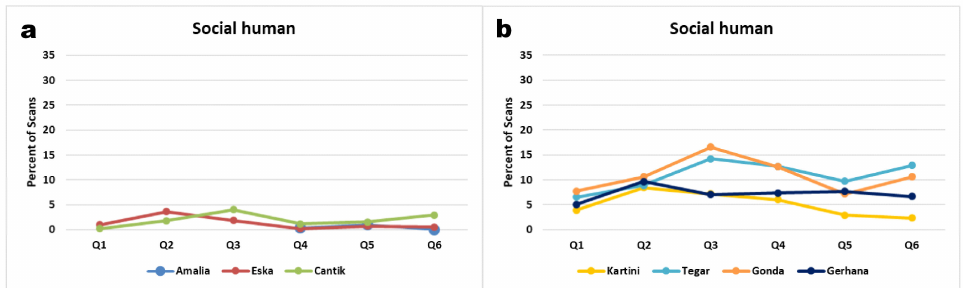
Figure 7. Development over time of social interaction frequency per juvenile ( a ) and infant ( b ), summarized across all human interaction partners. Amalia’s line (a, blue) is not visible, because it coincides with Eska’s (red, Q4–Q6). Same data base as in Figure 3.